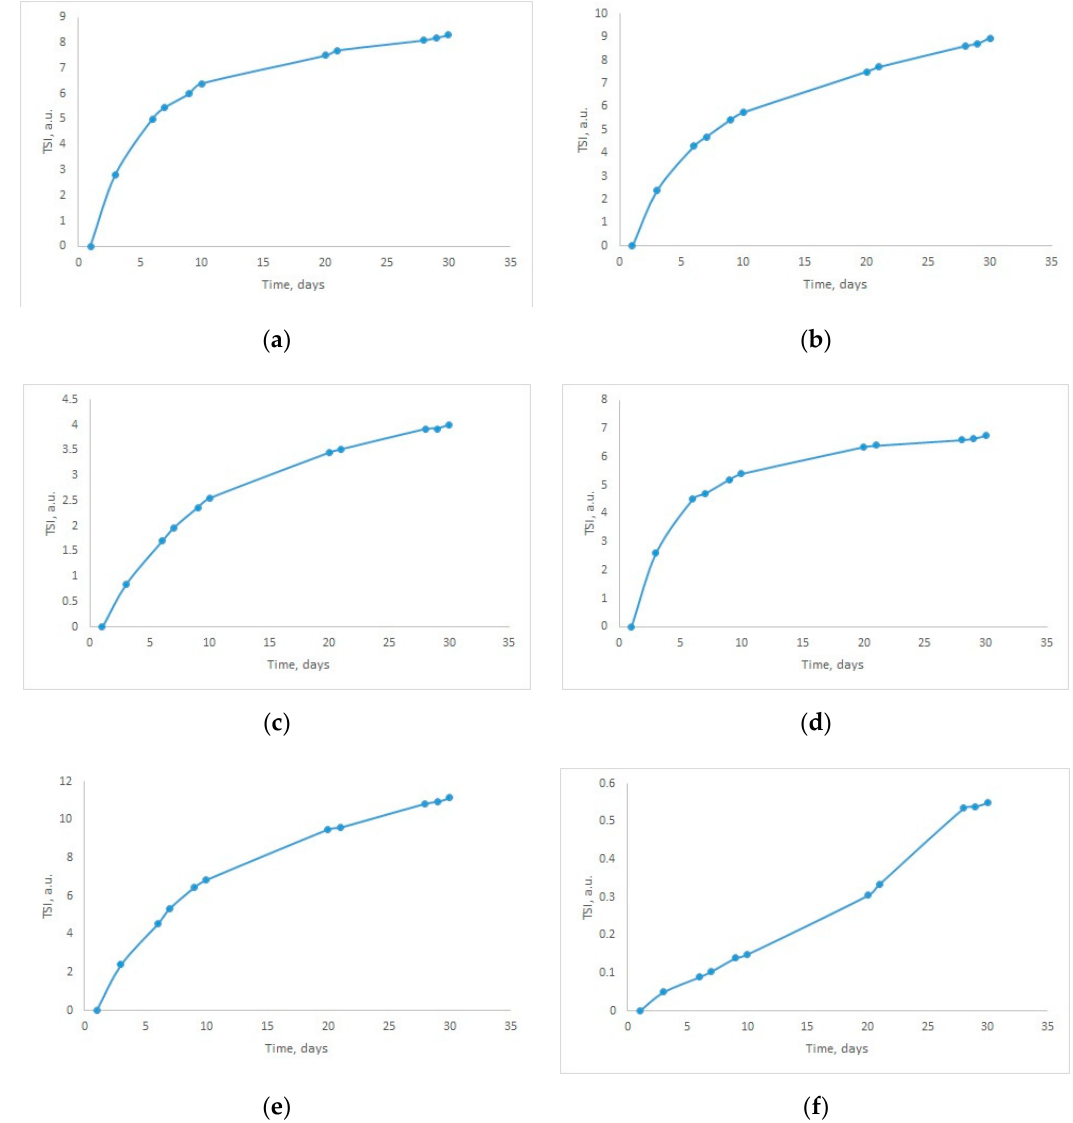
Figure 1. Stability analysis based on the TSI coefficient for the sample: ( a ) P1, ( b ) P2, ( c ) P3, ( d ) P4, ( e ) P5, and ( f ) P6.